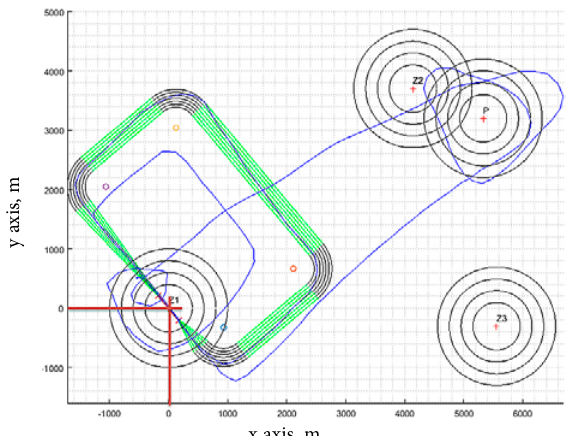
Fig. 7. Flight circuit in the ENU coordinate system with holding zones